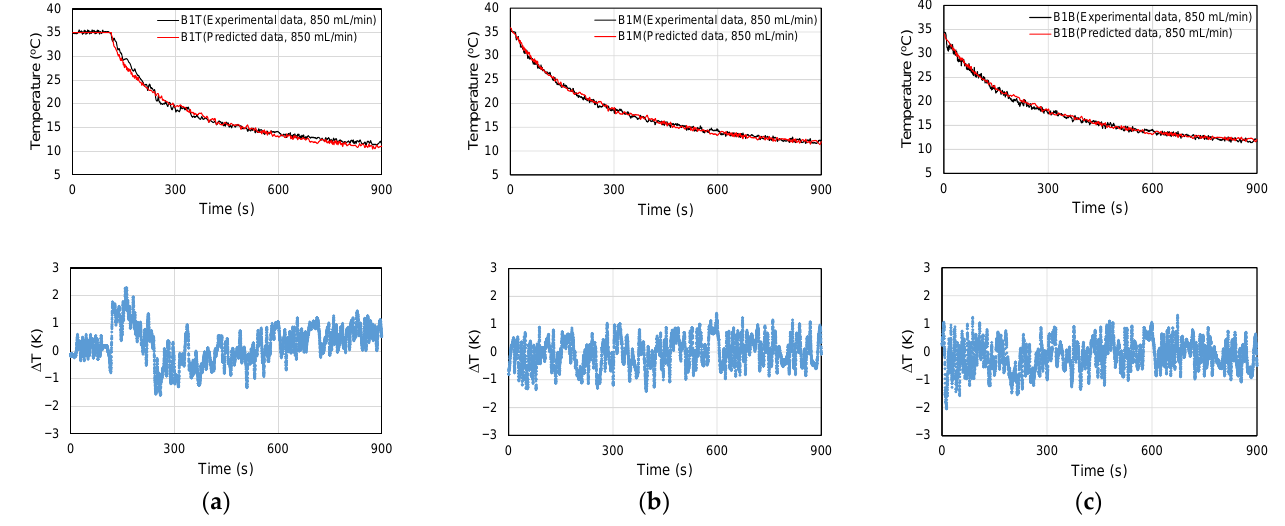
Figure 8. The results obtained using the model built at the flow rate of 770 mL/min to predict the data at the flow rate of 850 mL/min under the initial temperature of 35 °C: ( a ) top layer; ( b ) middle layer; ( c ) bottom layer.